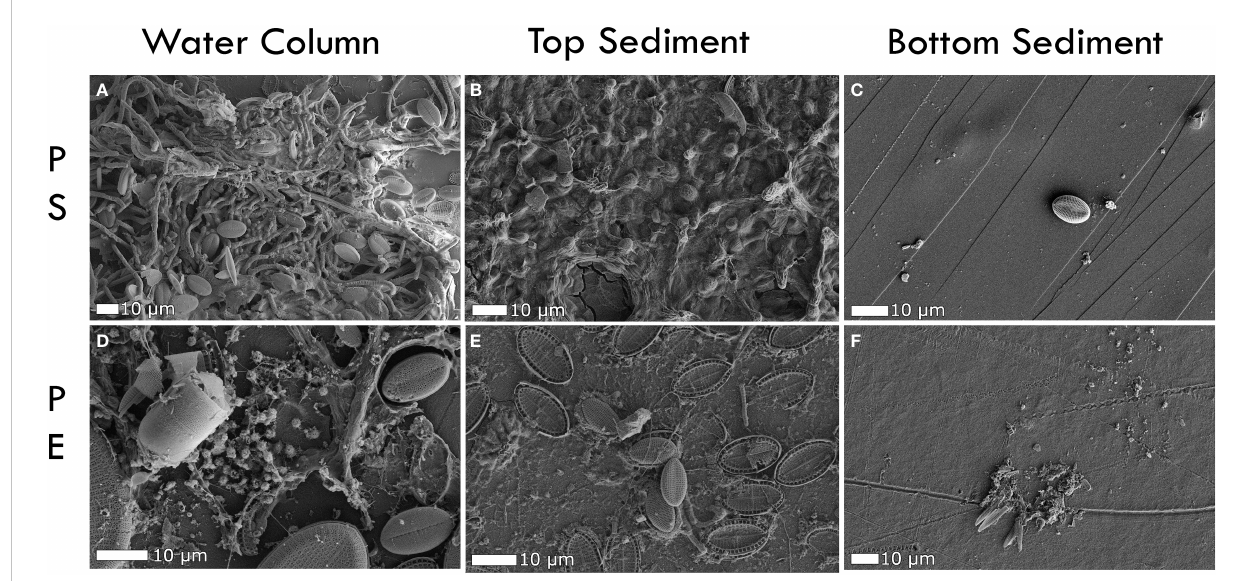
FIGURE 2 SEM-SE images of PE and PS plastics exposed to the water column and sediment for 6 months without metal encasement. (A) PS in the surface water showing mixed colonization of microorganisms (B) PS in the top sediment, largely dominated by coccoid shaped cells, (C) PS in the deep sediment showing a diatom, but minimal surface coverage apart from some small grains, (D) A mixed community on the surface of a PE sheet exposed to the water column, (E) Fragmented diatoms on the surface of a PE sheet in the top sediment, (F) Some diatom fragments and grains on the PE